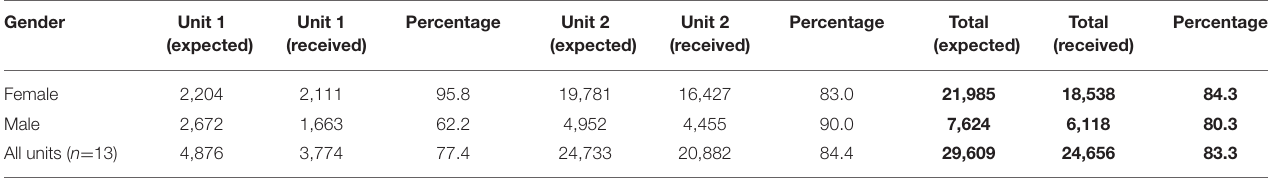
TABLE 4 | Proportions of expected and received GPS fixes from geofence-enabled lion tracking collars.